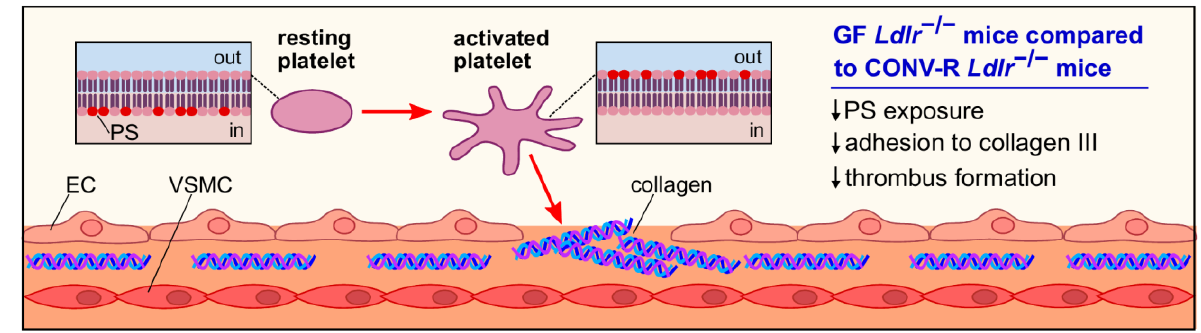
FIGURE 2: Platelet activation and adhesion in GF and CONV-R Ldlr -/- mice. Platelet activation is accompanied by the flipping and exposure of the procoagulant phosphatidylserine from the inner to the outer leaflet of the membrane. Compared to CONV-R counterparts, GF Ldlr -/- mice show reduced phosphatidylserine exposure, yielding in a lower adhesion of platelets to subendothelial type III collagen and impaired throm- bus formation. Abbreviations: PS, phosphatidylserine; EC, endothelial cell; VSMC, vascular smooth muscle